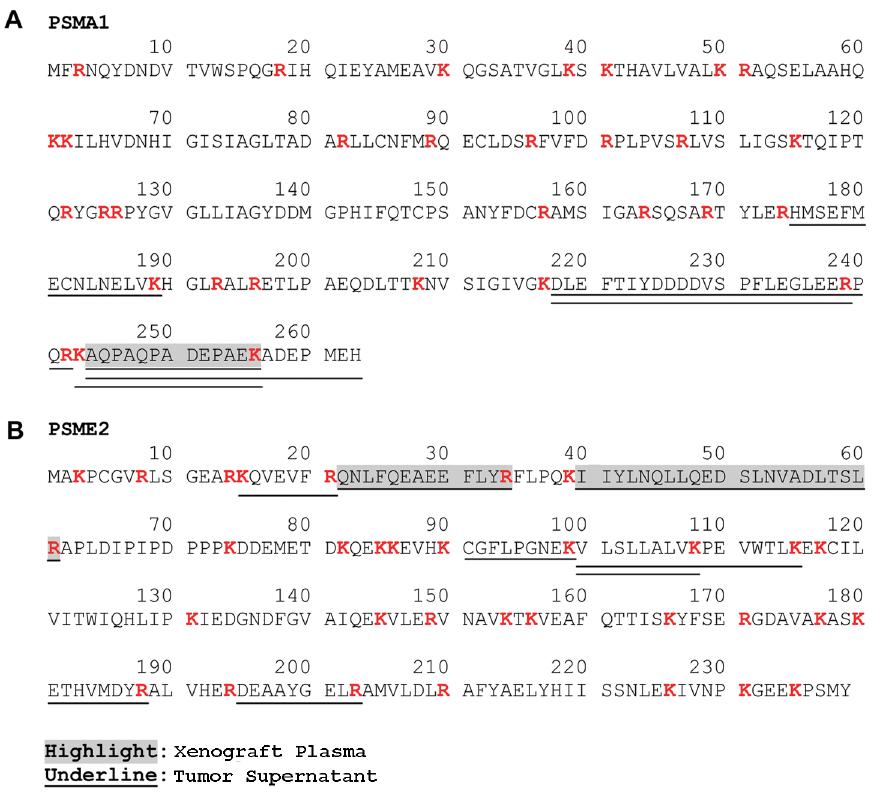
Figure 3. Sequence coverage for selected human proteins from the xenograft plasma and tumor supernatants. Examples of candidate biomarkers, PSMA1 and PSME2, where increased sequence coverage is obtained from analysis of the tumor supernatant (underlined peptides) compared to the xenograft plasma (grey highlight). Tryptic sites (K or R) are indicated in red.